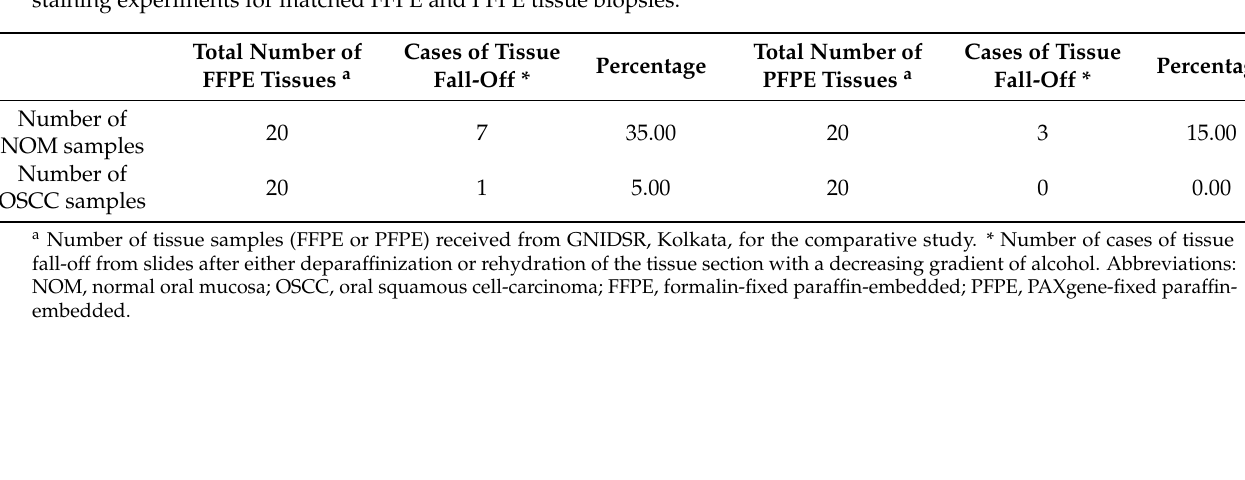
Table 2. Documentation of cases of tissue section fall-off from slides during the sample processing steps for histochemical staining experiments for matched FFPE and PFPE tissue